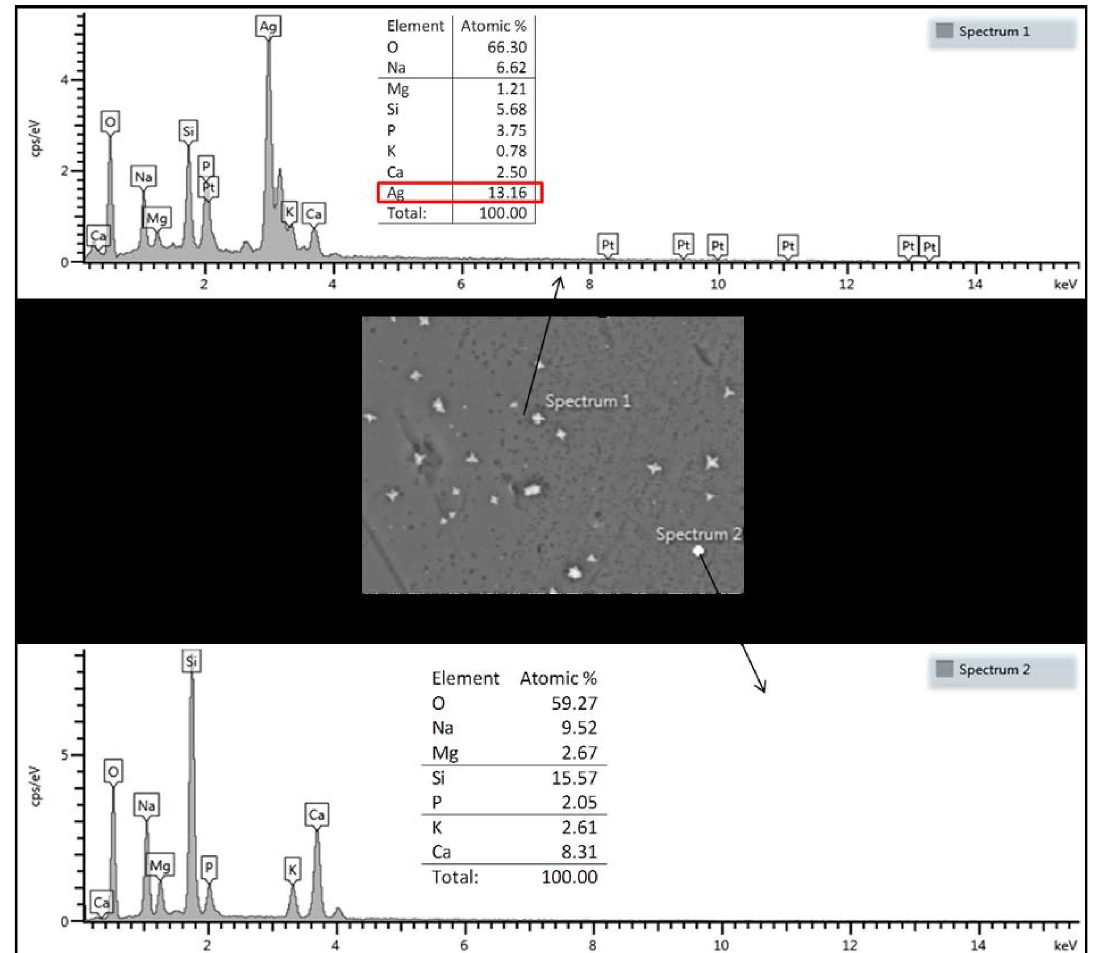
Figure 4. EDS analyses on CEL2 + pad (1 mg / mL) +